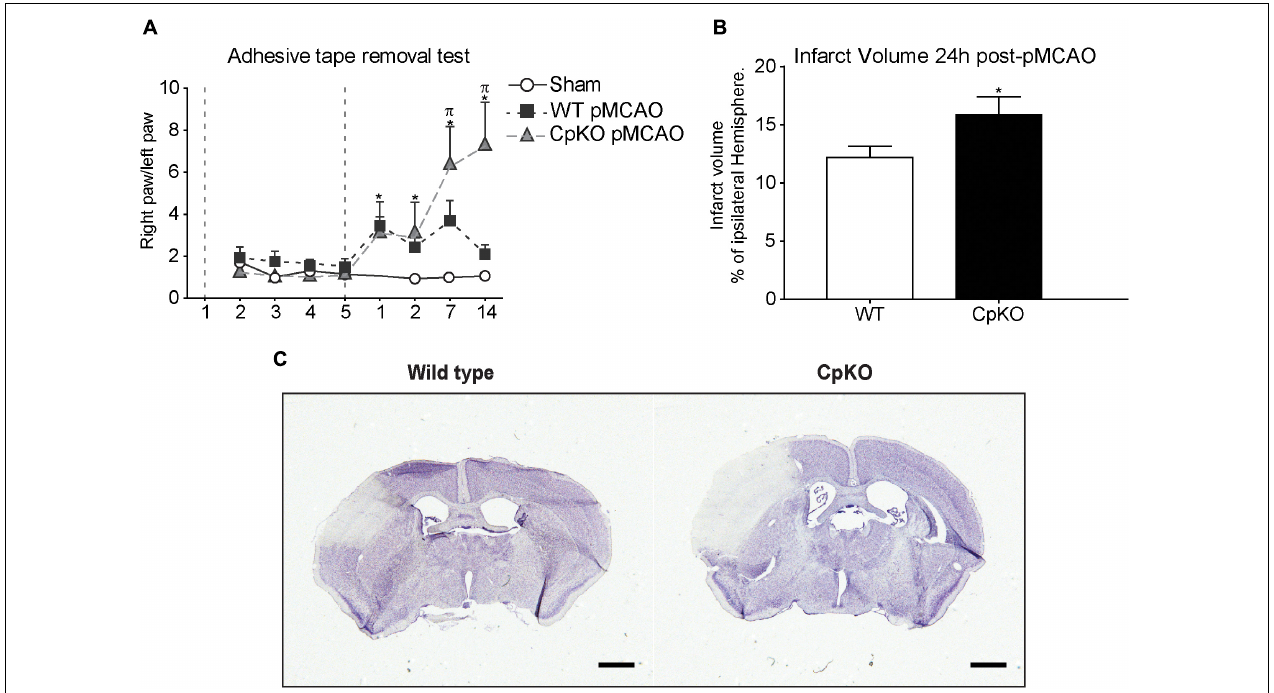
FIGURE 1 | (A) Graph showing functional recovery assessed with the “adhesive-tape removal” test. Mice were trained for 5 days prior to the surgery for pMCAO (period indicated between the two vertical dashed lines). At days 1 and 2 after pMCAO wildtype and Cp KO mice both show similar deficits. Wildtype mice recover to normal values by day 14, while CpKO mice show increasing functional deficits at 7 and 14 days. The sham animals show no deficits. (B) Cp null mice show significantly larger lesion size as compared to wildtype mice at 24 h after pMCAO. (C) Nissl stained sections showing the ischemic lesion in wildtype and Cp KO mice 24 h after pMCAO. n = 13–15 per group in A ; and 9 per group in B . Two-way ANOVA was used to analyze results in A, followed by Bonferroni’s post hoc test. ∗ p -value ≤ 0.05 compared to sham-control group; π p -value ≤ 0.05 compared to wild-type group. Mann–Whitney test was used to compare WT vs. CpKO in B. ∗ p -value ≤ 0.05; scale bar = 100 µ